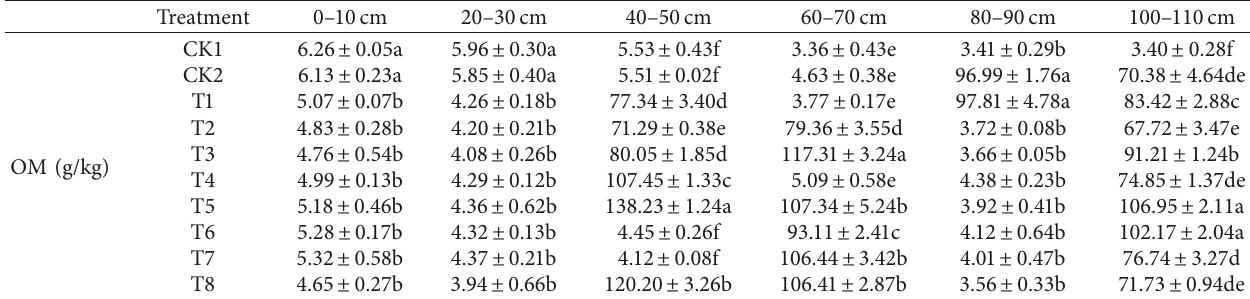
Table 7: Organic matter of soil and coal gangue of interlayered soil profiles.